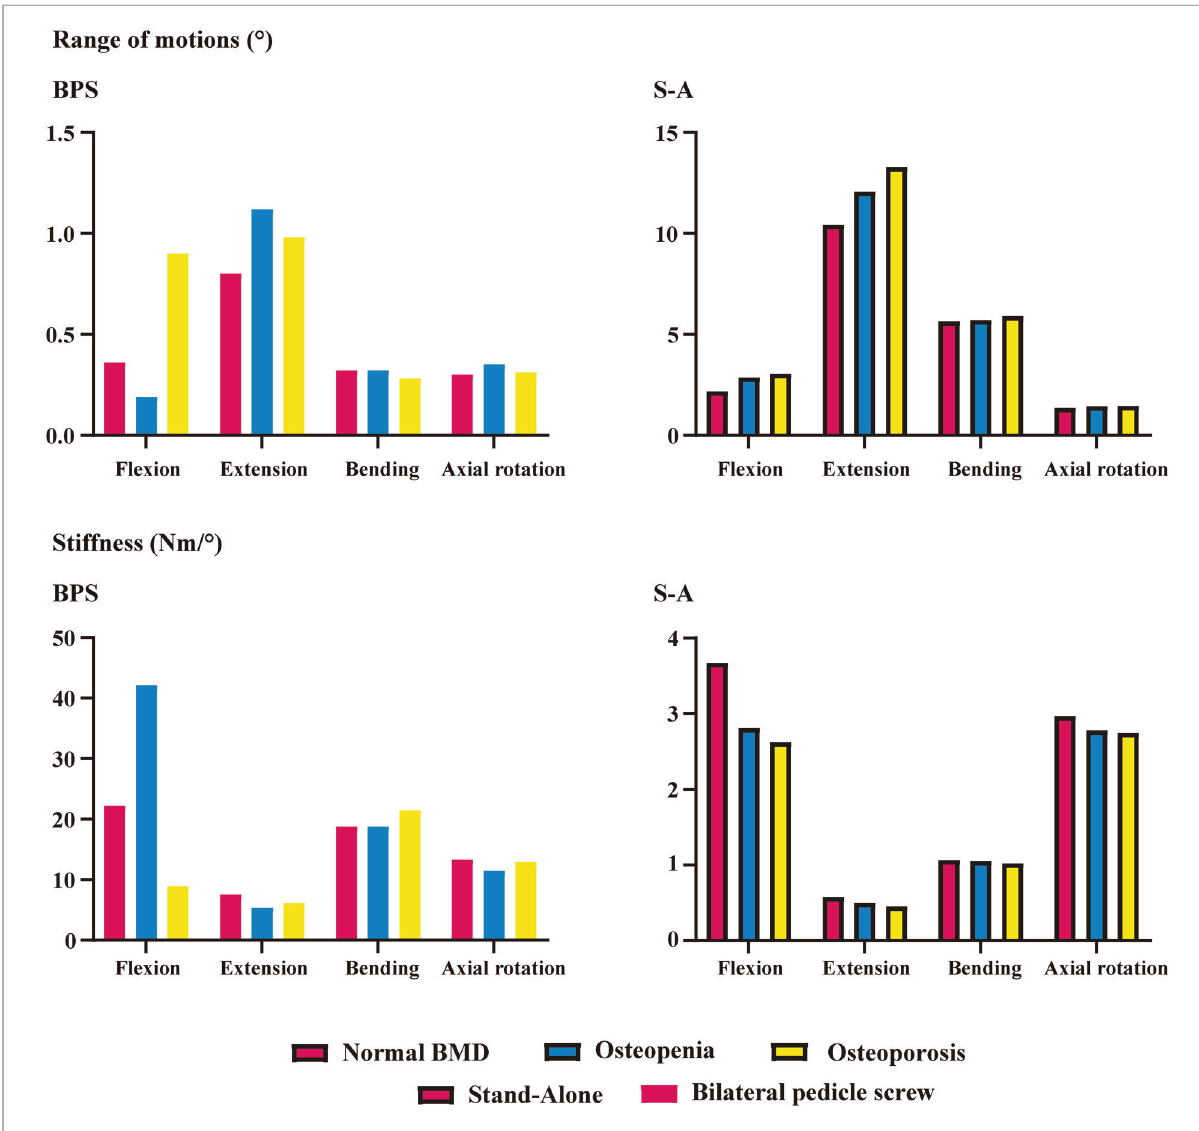
FIGURE 3 ROMs and stiffness of the motion segment caudal to the surgical segment (L5 –